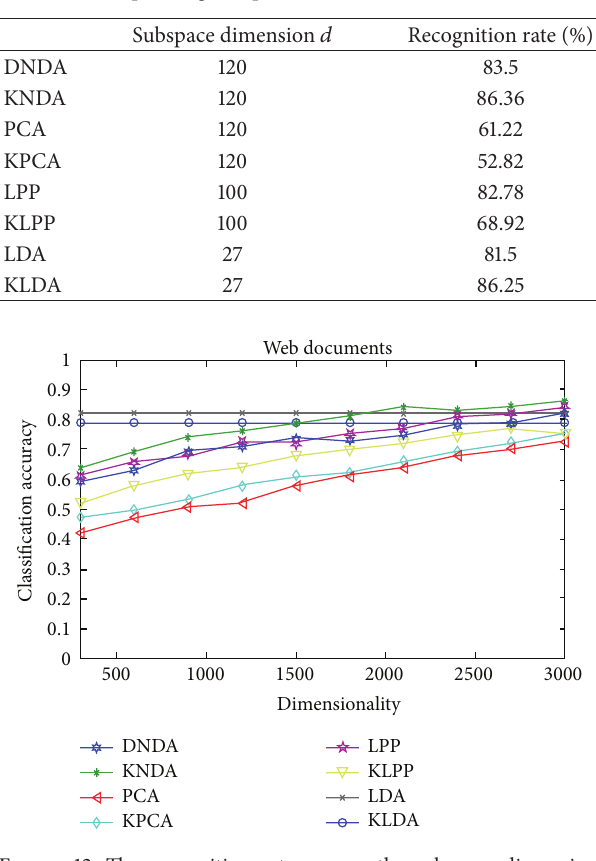
Figure 12: The recognition rates versus the subspace dimension on random downloaded Web documents which belonged to 25 different